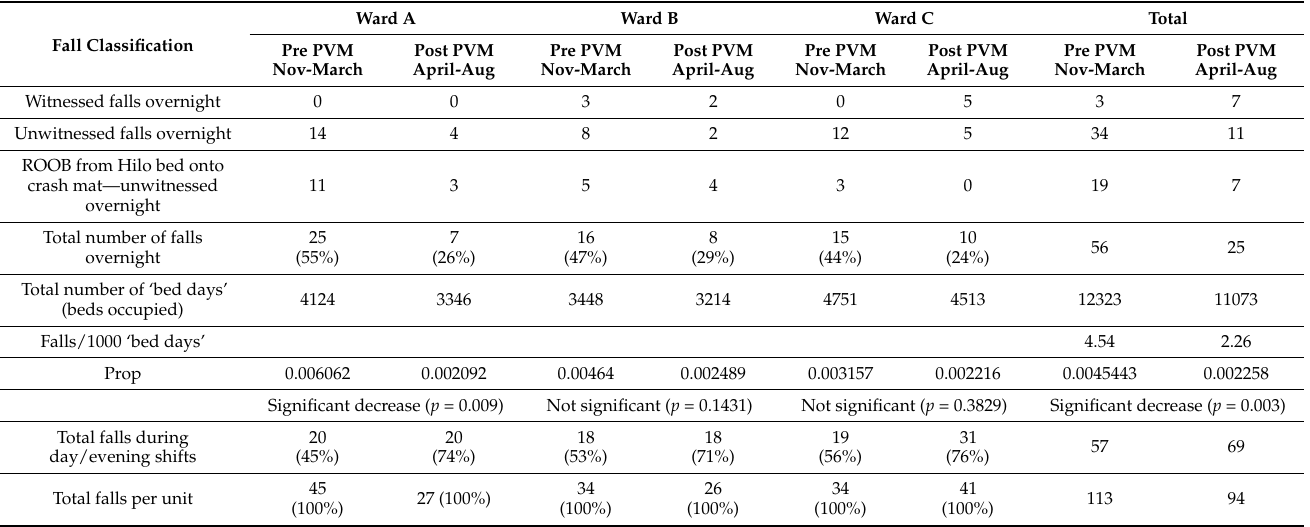
Table 1. Overall comparison of total inpatient falls data overnight and pre and post PVM implemen- tation.